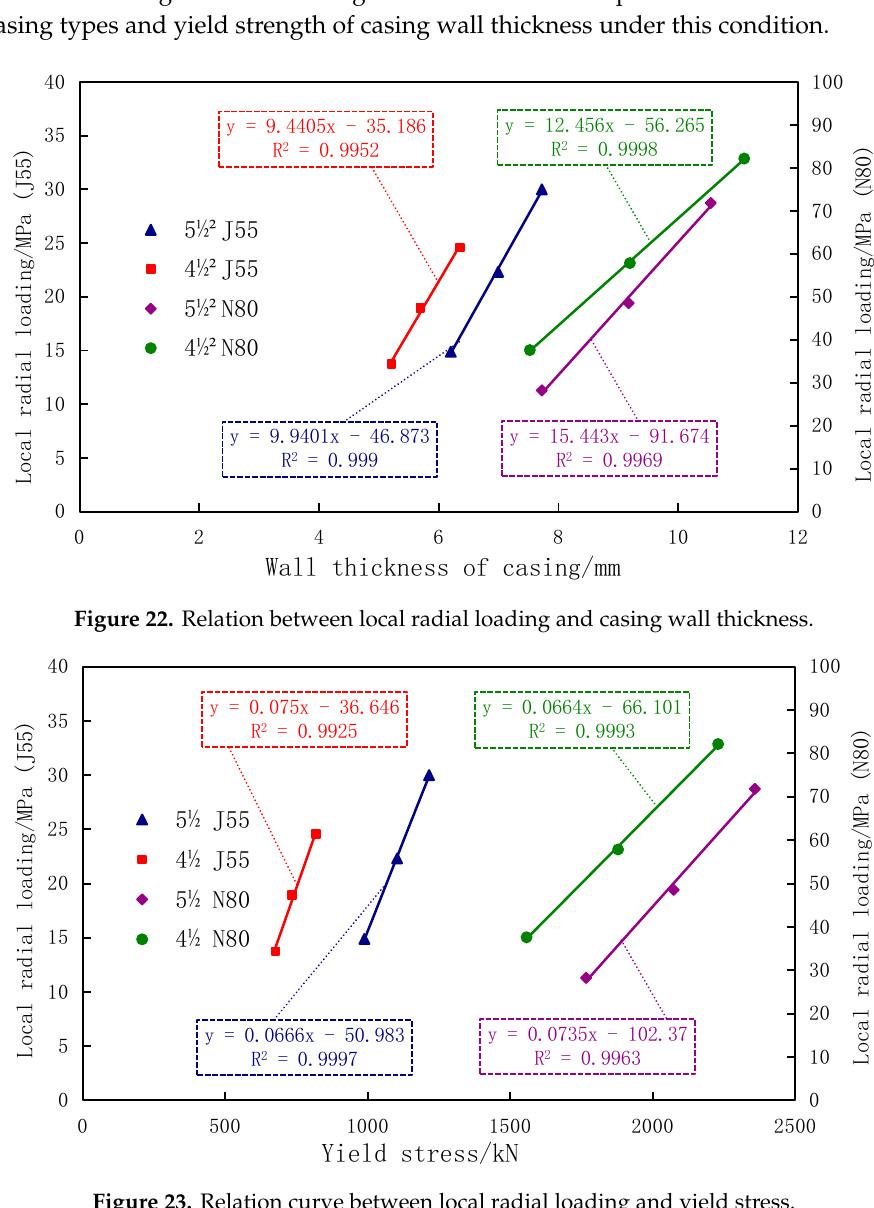
Figure 21. Relationship between absolute intensity-reduction value and maximum deformation.